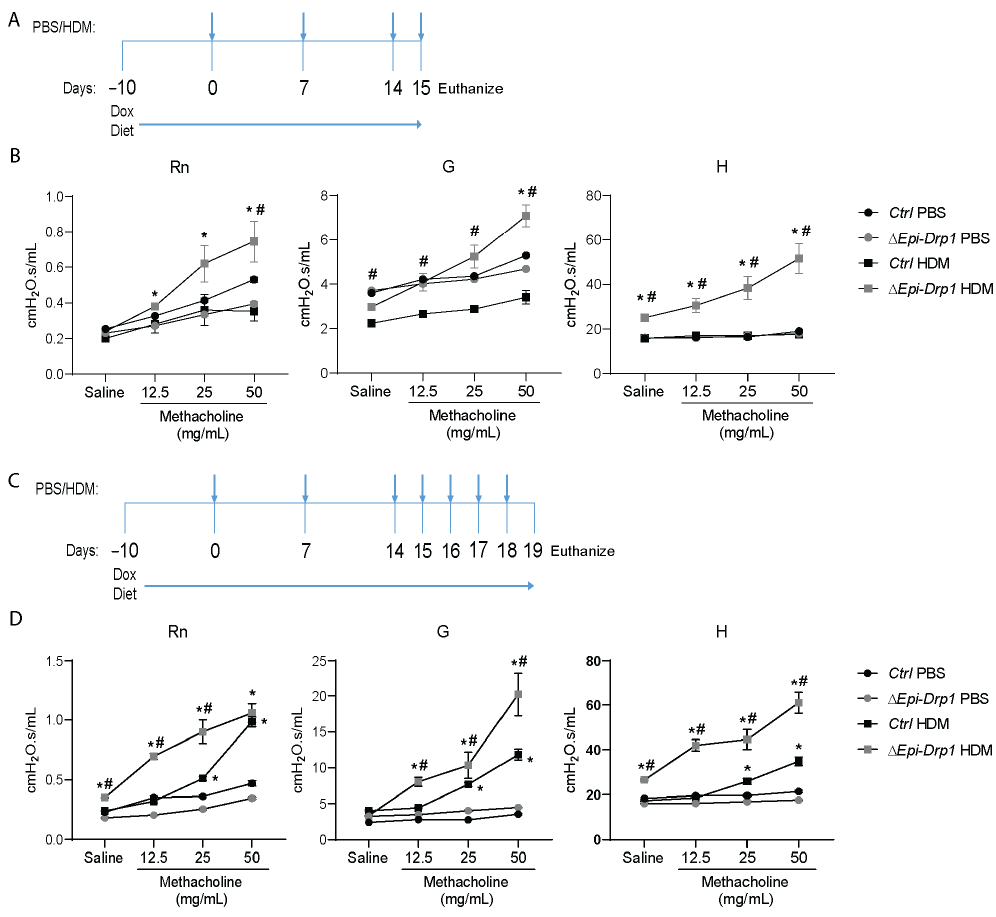
Figure 5. Epithelial specific Drp1 deletion enhances AHR in mouse lungs in response to HDM. ( A ) Deletion and HDM exposure protocol for AHR initiation experiment; ( B ) Results from AHR initiation experiment, n = 5 mice per group from 2 experiments; ( C ) Deletion and HDM exposure protocol for established AHR experiment; ( D ) Results from AHR initiation experiment, n = 4 mice per Δ Epi-Drp1 group and n = 6 for remaining groups from 2 experiments. ( B,D ) * p < 0.05 vs. corresponding PBS group, # p < 0.05 vs. Ctrl HDM group. Error bars represent mean ± SEM.